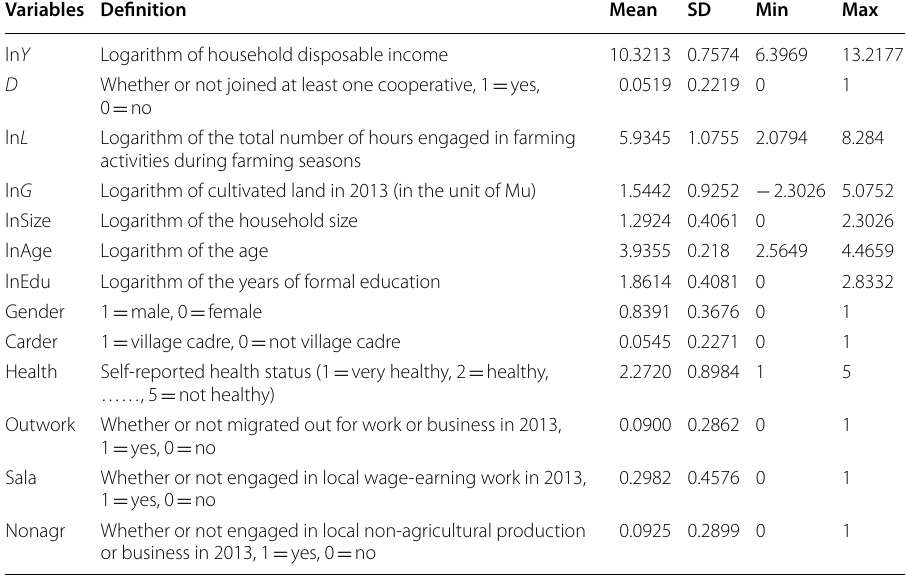
Table 1 Variable definition and descriptive statistics